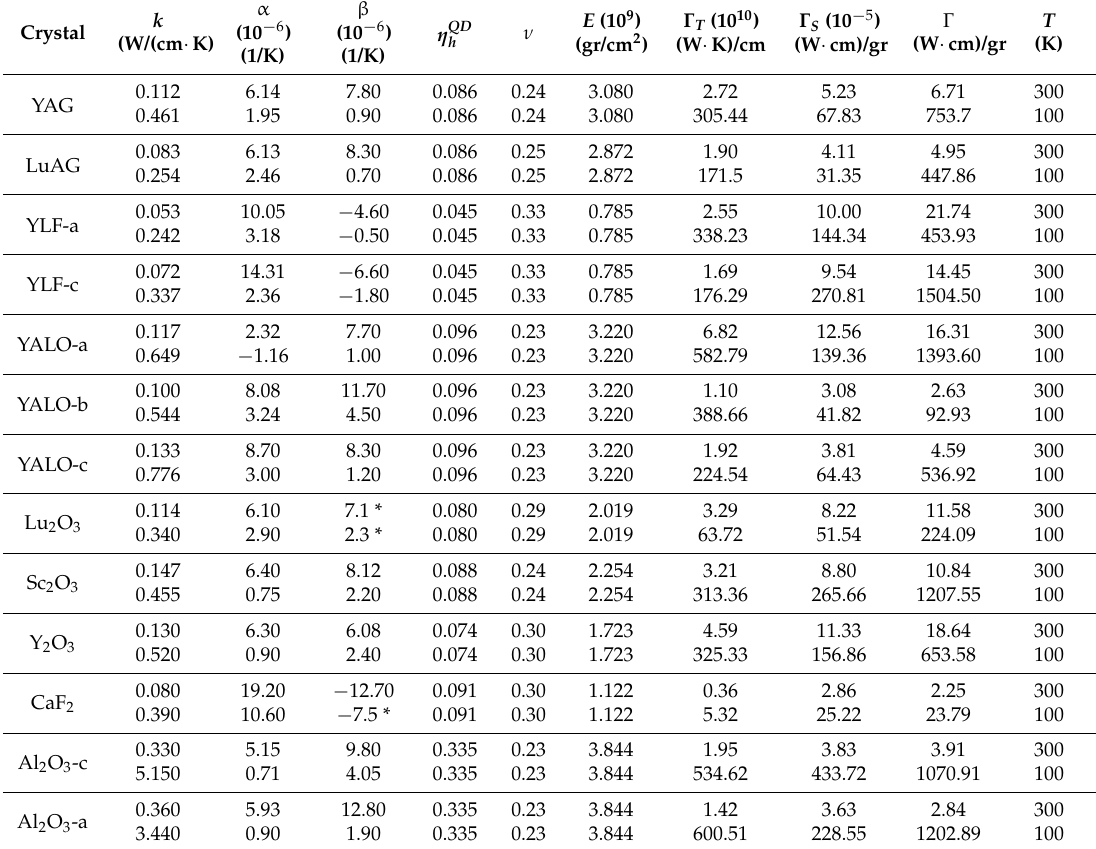
Table 3. Thermal Conductivity k , thermal expansion coefficient α , thermo-optic coefficient β , quantum defect heat fraction η QD , Poisson’s ratio ν , Young’s Modulus E , and calculated Figures of Merit Γ T , Γ S , h and Γ for selected laser crystals at 100 and 300 K. Absolute values of negative parameter values were used to calculate